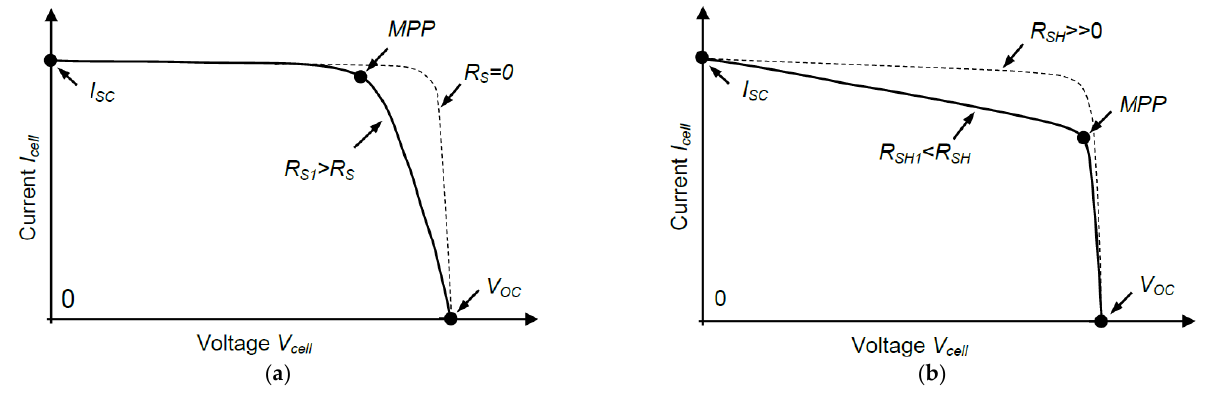
Figure 3. Effect of parasitic resistances R s and R sh on the I – V characteristics ’ shape: ( a ) Effect of series resistance R s for the MPP – V OC slope; ( b ) Effect of shunt resistance R sh for the MPP – I SC slope.